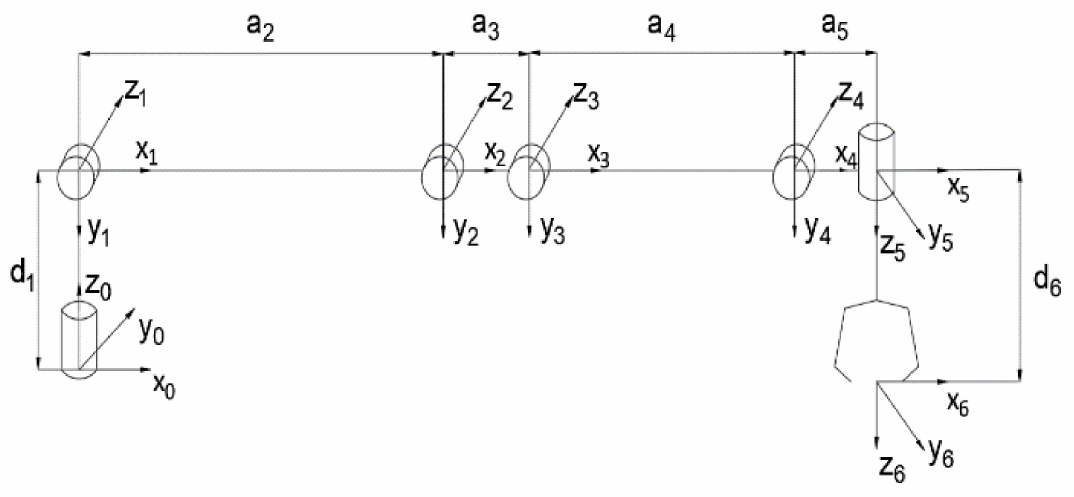
Figure 3. Structure sketch of the manipulator containing a virtual